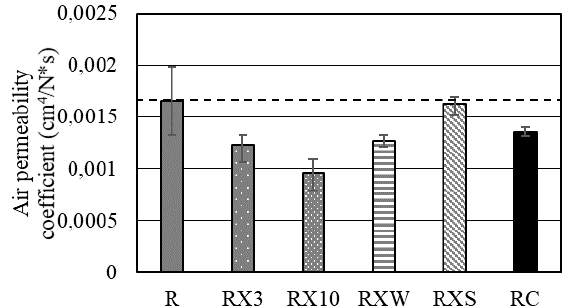
Figure 6. Air permeability coe ffi cient (horizontal).